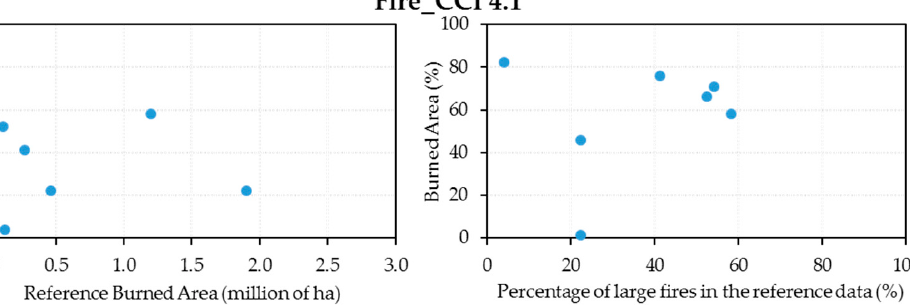
Figure 7. Scatterplots of the annual burned area percentages for the four products analyzed against the annual reference burned area (left) and versus the percentage of burned area of ≥ 10.000 ha fires (right). To analyze the temporal correlation of the reference data, the temporal distribution of the annual BA for the di ff erent products are represented along with the reference data (Figure 8). All products conformed to the temporal pattern of the AFS reference data, with determination coe ffi cients of 0.991 (Fire_CCI 5.1), 0.987 (MCD64A1), 0.973 (MCD45A1) and 0.817